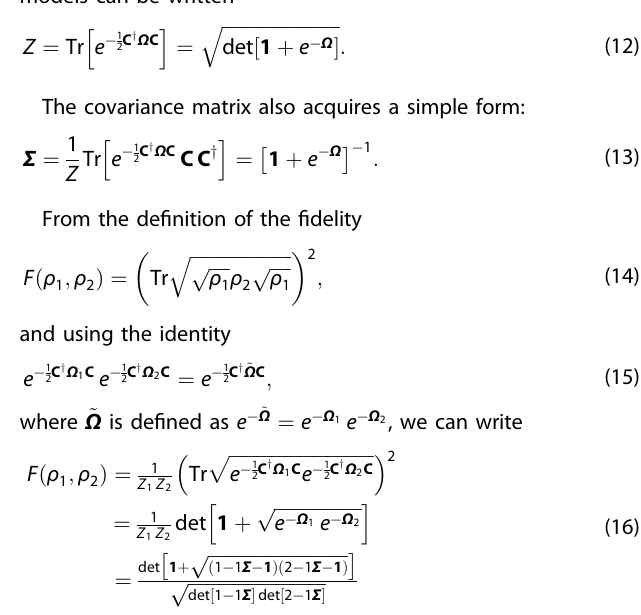
ffiffiffiffiffiffiffiffiffiffiffiffiffiffiffiffiffiffiffi p h e (cid:3) Ω 1 e (cid:3) Ω 2 ffiffiffiffiffiffiffiffiffiffiffiffiffiffiffiffiffiffiffiffiffiffiffiffiffiffiffiffiffiffiffi 1 (cid:3) 1 Σ (cid:3) 1